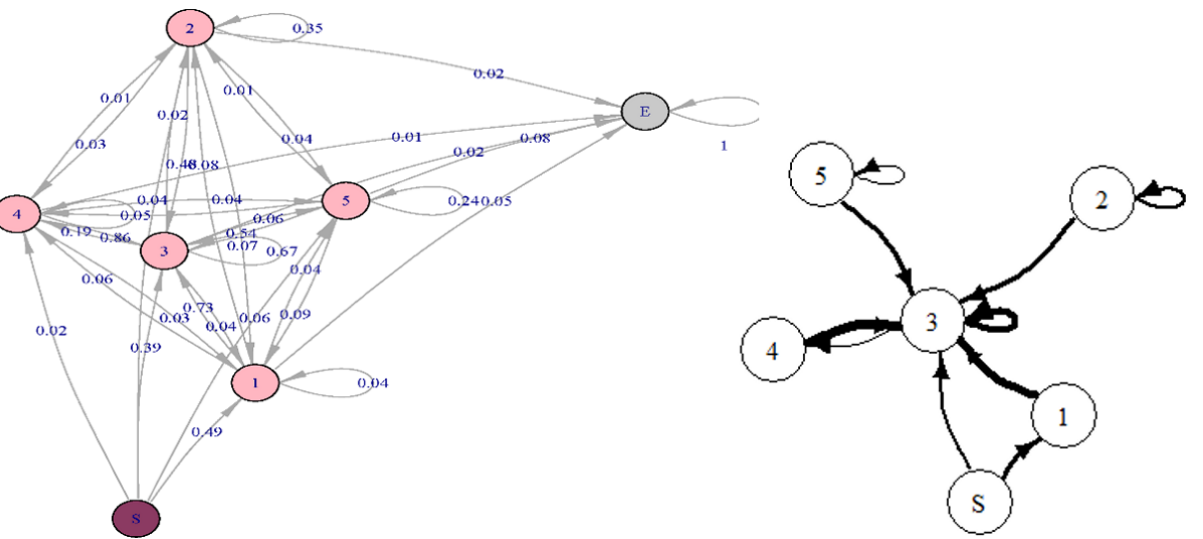
Figure 5. Markov chain for all children who played level 1 (n=50): (left) detailed plot with all transitions and (right) simplified plot with transition probabilities >0.1. The thickness of the lines is proportional to the transition probability.